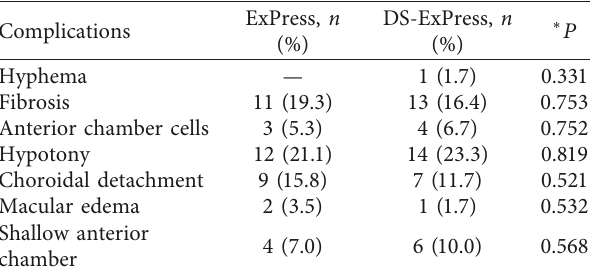
Table 7: Postoperative complications.